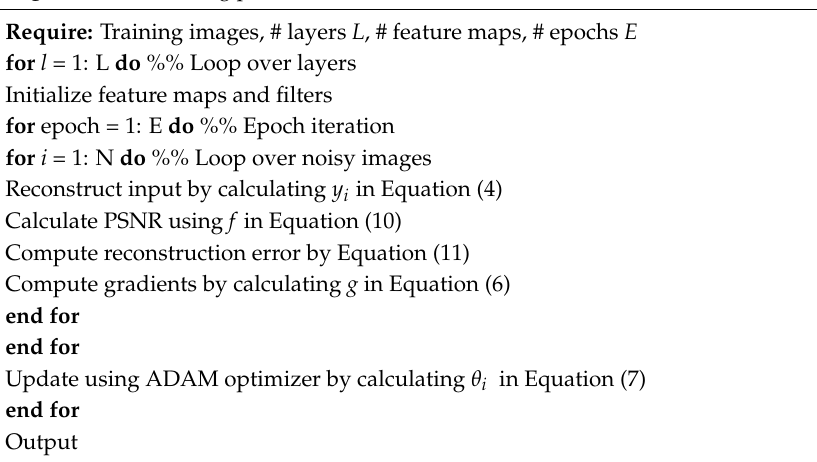
Algorithm 1. Learning procedure of FSCN